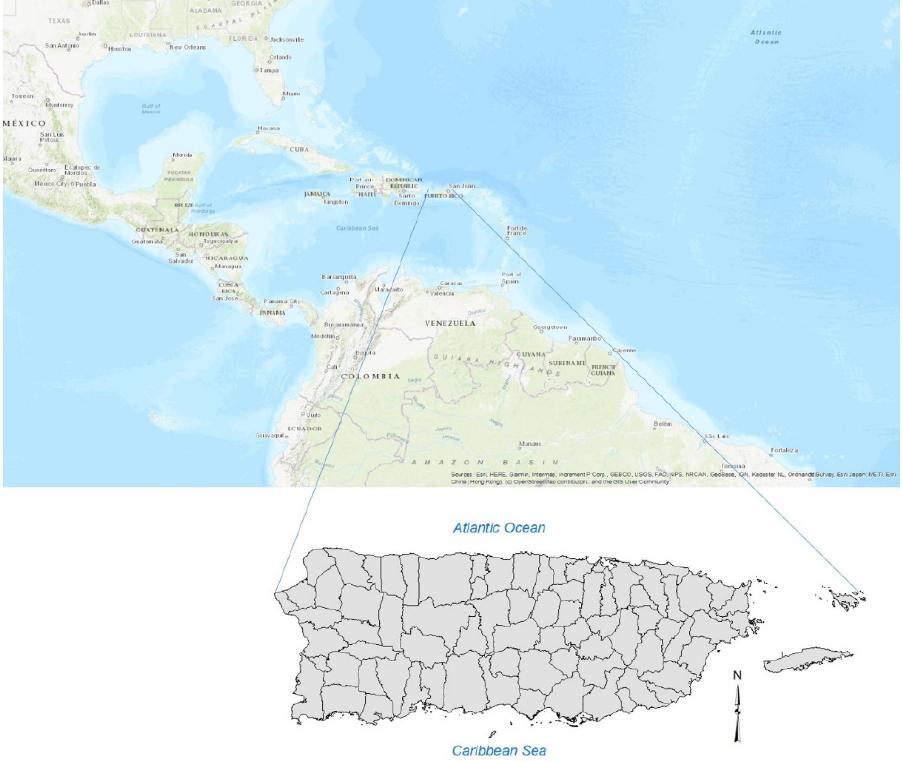
Figure 1. Puerto Rico base map.